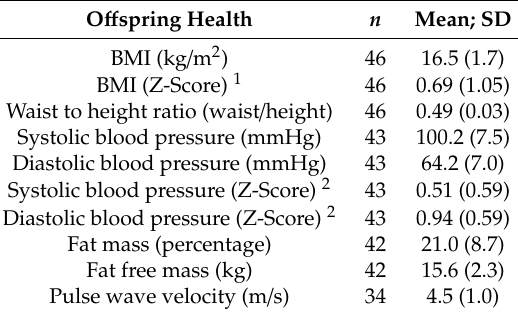
Table 2. O ff spring cardiovascular health outcomes at the ages 3–6 years